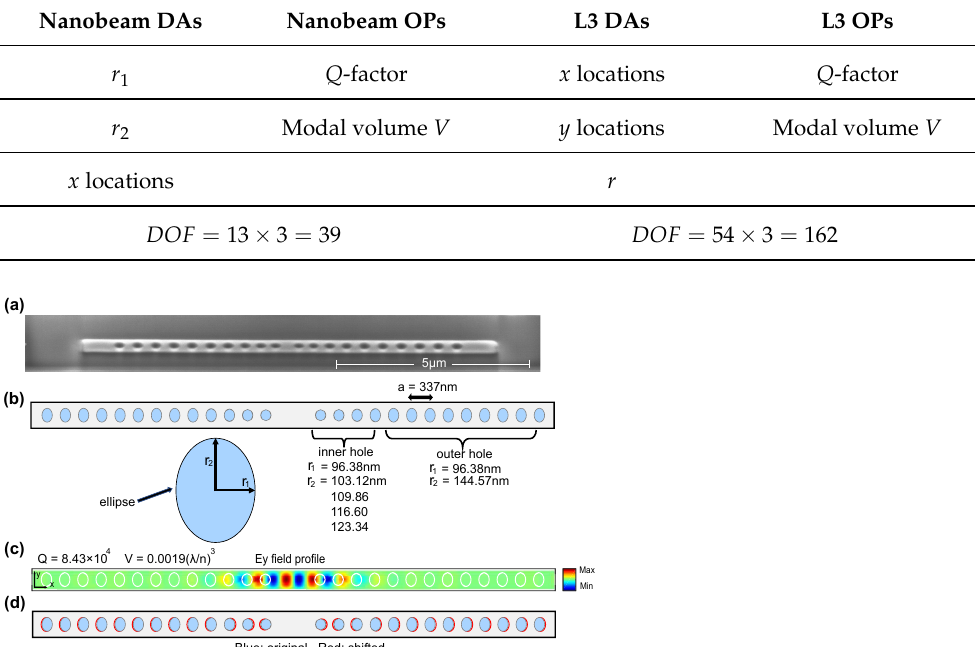
Figure 4. Nanobeam structure. ( a ) SEM image of an actual fabricated nanobeam by us. ( b , c ) The initial structure’s design parameters and optical properties, respectively. As shown, holes are elliptically shaped with r 1 and r 2 as its two axes. ( d ) A sample in the dataset with randomly shifted holes. Blue: original holes; red: shifted holes.